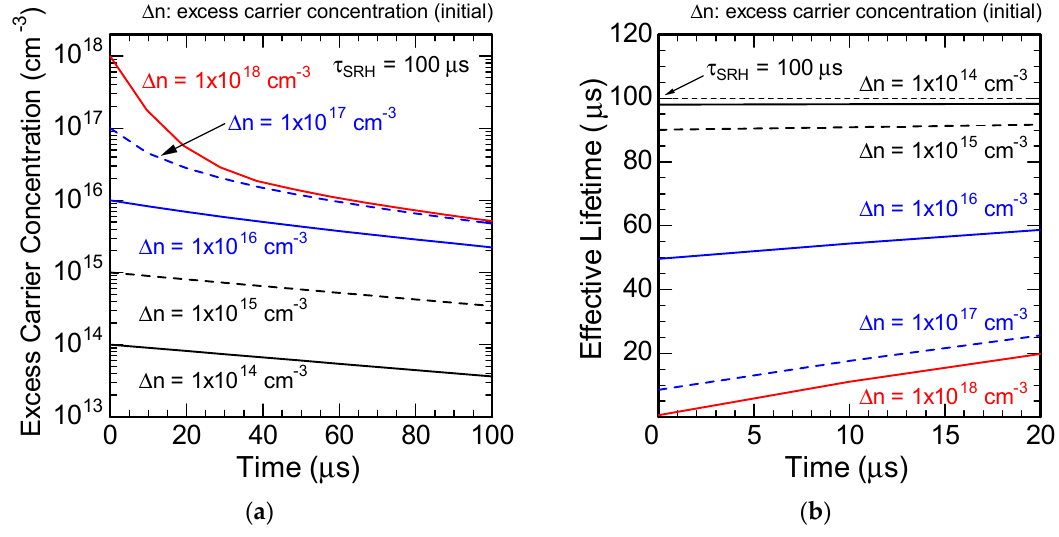
Figure 11. ( a ) Decay curves of the excess carrier concentration in n-type SiC having a long SRH lifetime of 100 µs for several different initial excess carrier concentrations from 1 × 10 14 cm − 3 to 1 × 10 18 cm − 3 ; ( b ) Effective carrier lifetime as a function of time for several different initial excess carrier concentrations.